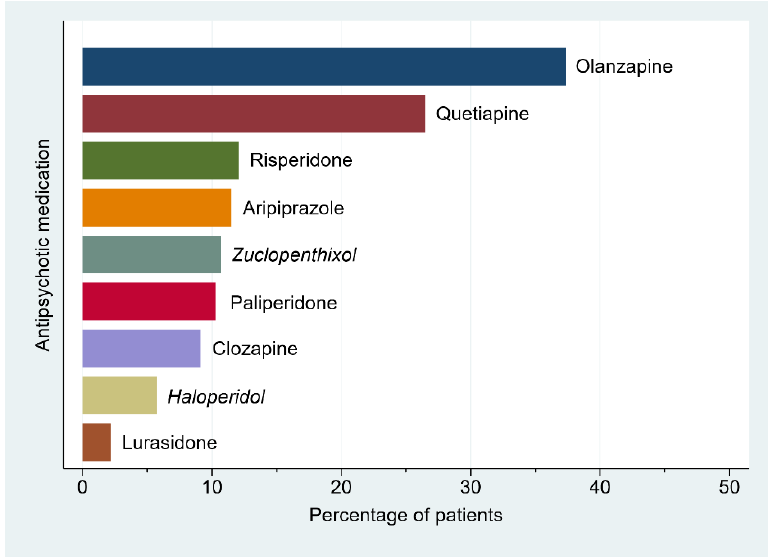
Figure 2. Distribution of inpatient antipsychotic medication use ( n = 506). First-generation antipsychotics are italicized. Antipsychotics with <1% frequency of use are not displayed, which included the first-generation antipsychotics: chlorpromazine, flupentixol, pericyazine, and droperidol; and the second-generation antipsychotics: brexpiprazole, asenapine, and amisulpride.